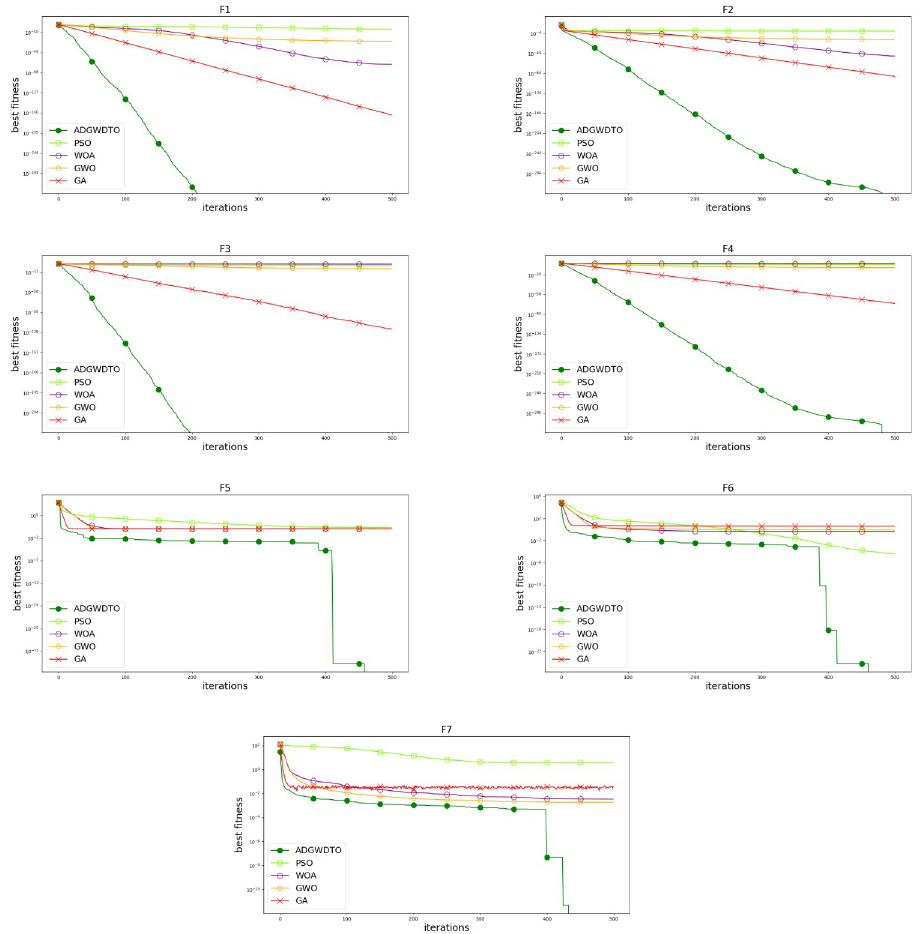
Fig 7. Proposed algorithm convergence curves versus other competing algorithms for the seven benchmark functions.